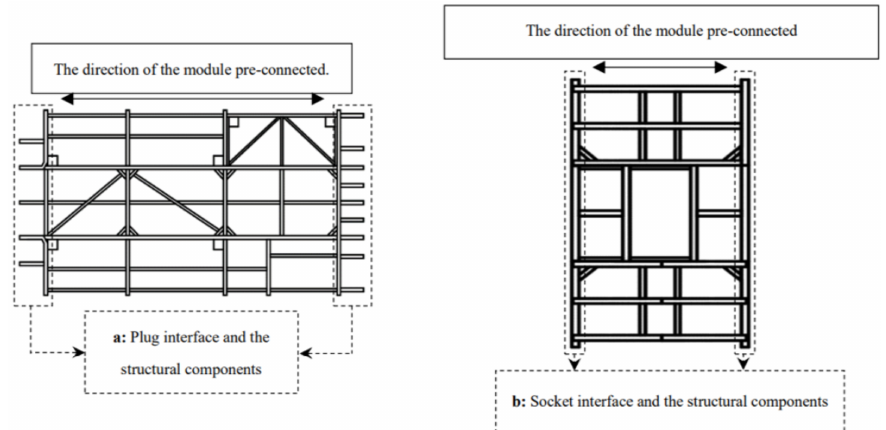
Figure 2. ( a ) Plug interface and the corresponding module, showing that the layout direction of the structural components is consistent with the pre-connected direction of the module, showing the top view of the middle frame module and the plug interface; ( b ) Socket interface and the corresponding module, showing that the layout directions of the structural components are perpendicular to the pre-connected direction of the module, showing the top view of the rear suspension frame module and the socket interface. The pre-connected direction in the figure refers to the direction that the module is ready to be assembled with other modules. For example, the middle frame module of bus chassis is ready to be connected with the front suspension or rear suspension frame module, so the front and rear directions of the module are the pre-connected directions.